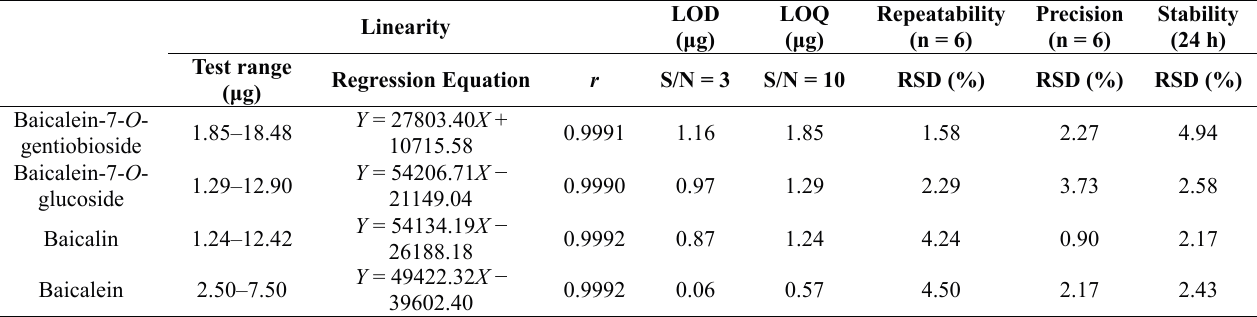
Table 2. Linearity, LOD, LOQ, repeatability, precision, and stability for four antioxidants in online post-column DPPH